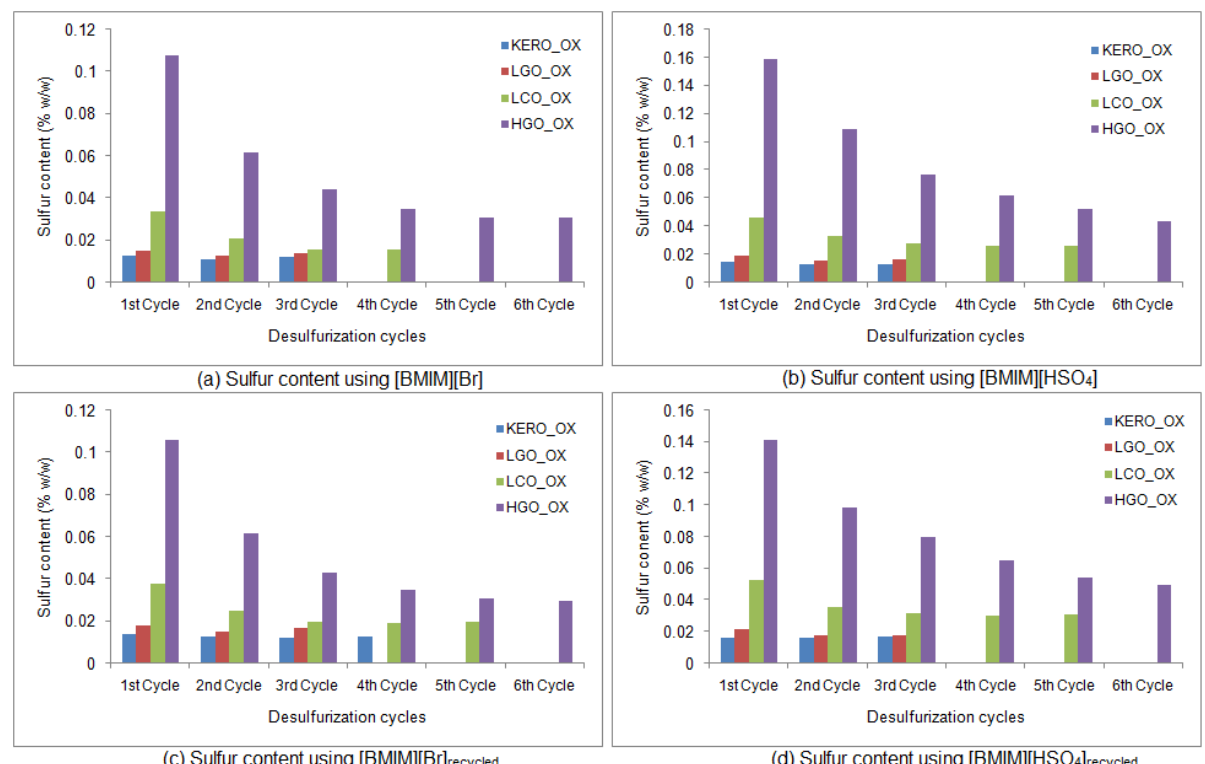
Figure 16. Desulfurization capability of the two fresh and the two recycled ionic liquids. Sulfur con- tent (% w / w ) of the surrogate raffinates during the extractions using: ( a ) [BMIM][Br], ( b ) [BMIM][HSO 4 ], ( c ) recycled [BMIM][Br], ( d ) recycled [BMIM][HSO 4 ]. (KERO_ OX: oxidized